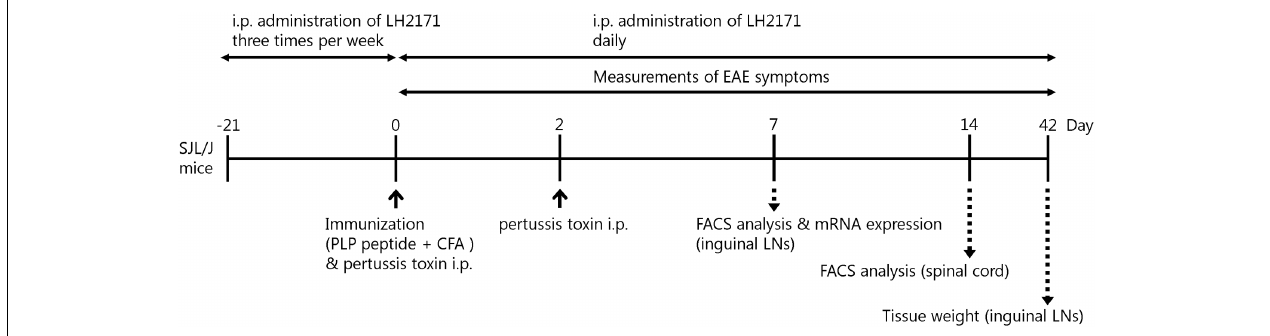
Frontiers in Microbiology |